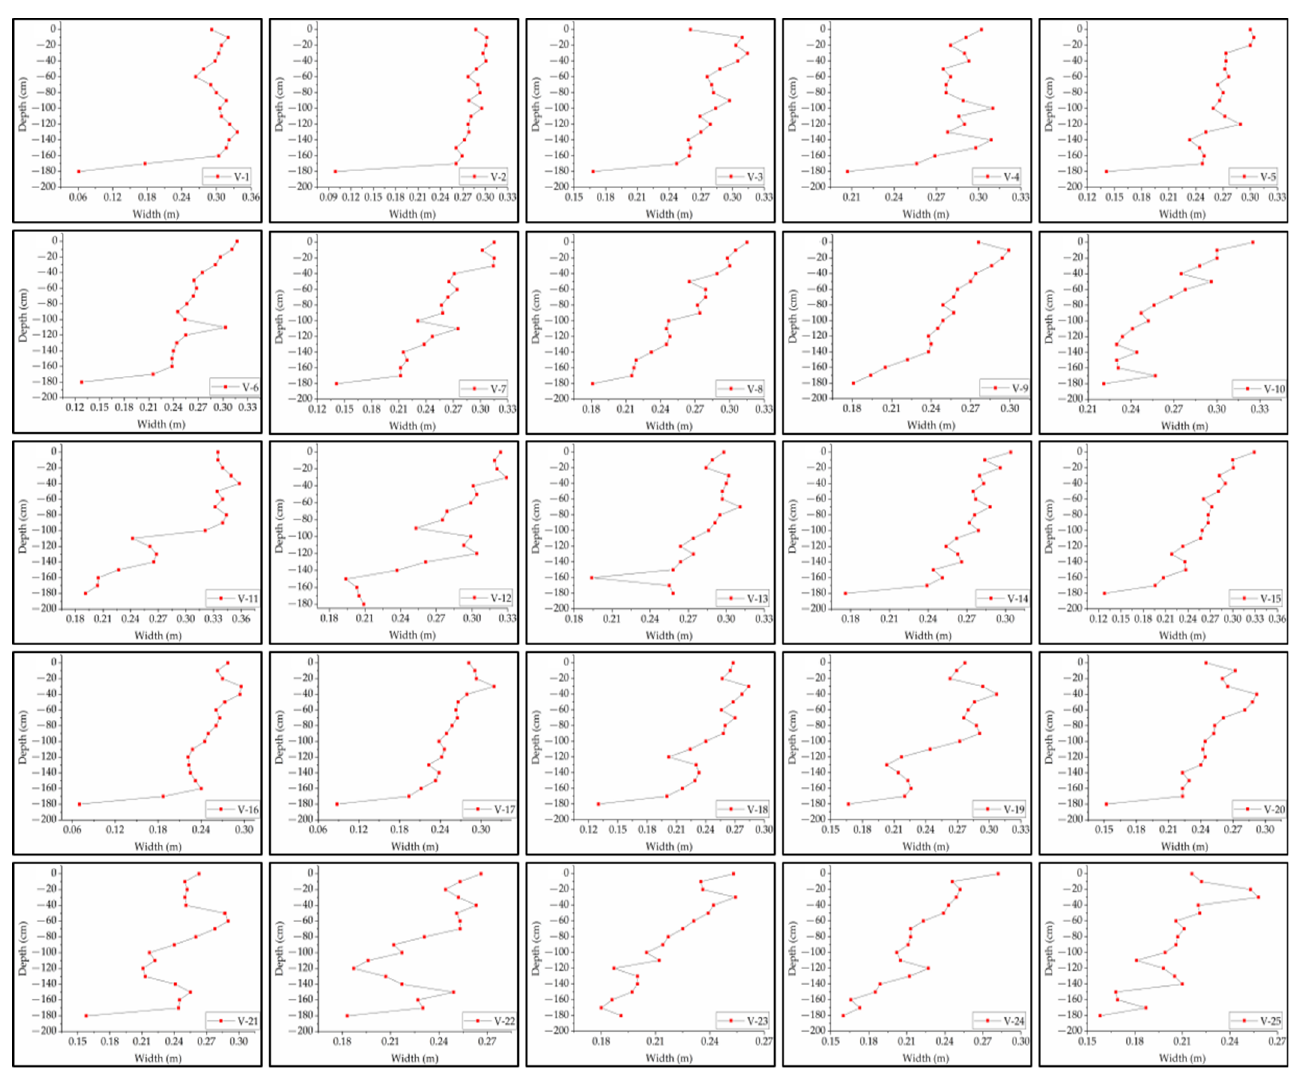
Figure 12. The frequency histogram of the ground fissure width.